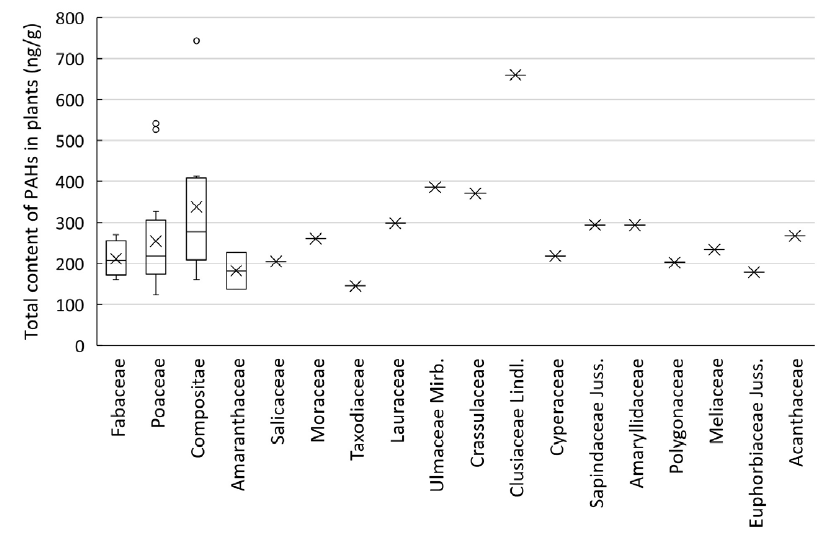
Figure 4. Total PAH contents in plants from different species. × means mean, ○ means outlier and - means median; except for Fabaceae, Poaceae, Compositae and Amaranthaceae, there was only one plant sample for other families.